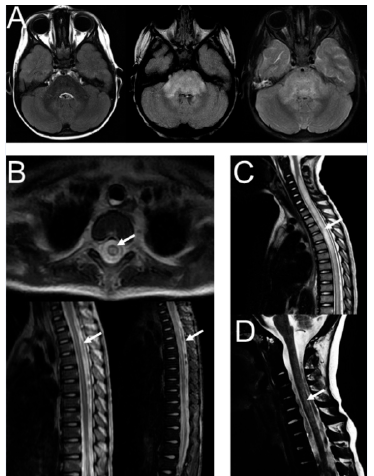
Figure 2. Imaging results of patients with severe CNS neurotoxicities during immunotherapy with DB and scIL-2. ( A ) Patient 1. MRI of brain showing inflammation and oedema of mesencephalon, pons and medulla oblongata. ( B ) Patient 3. Frontal and sagittal MRI of spinal cord, with hyperin- tensive zone in STIR- and T2-weighted images. ( C , D ) Patient 2 and 4, respectively. Sagittal MRI of spinal cord, with hyperintensive zone in T2-weighted images. Arrows indicate areas of inflamma- tory response. DB, dinutuximab beta; CNS, central nervous system; MRI, magnetic resonance im- aging; scIL-2, subcutaneous interleukin-2; STIR, short-TI inversion recovery.